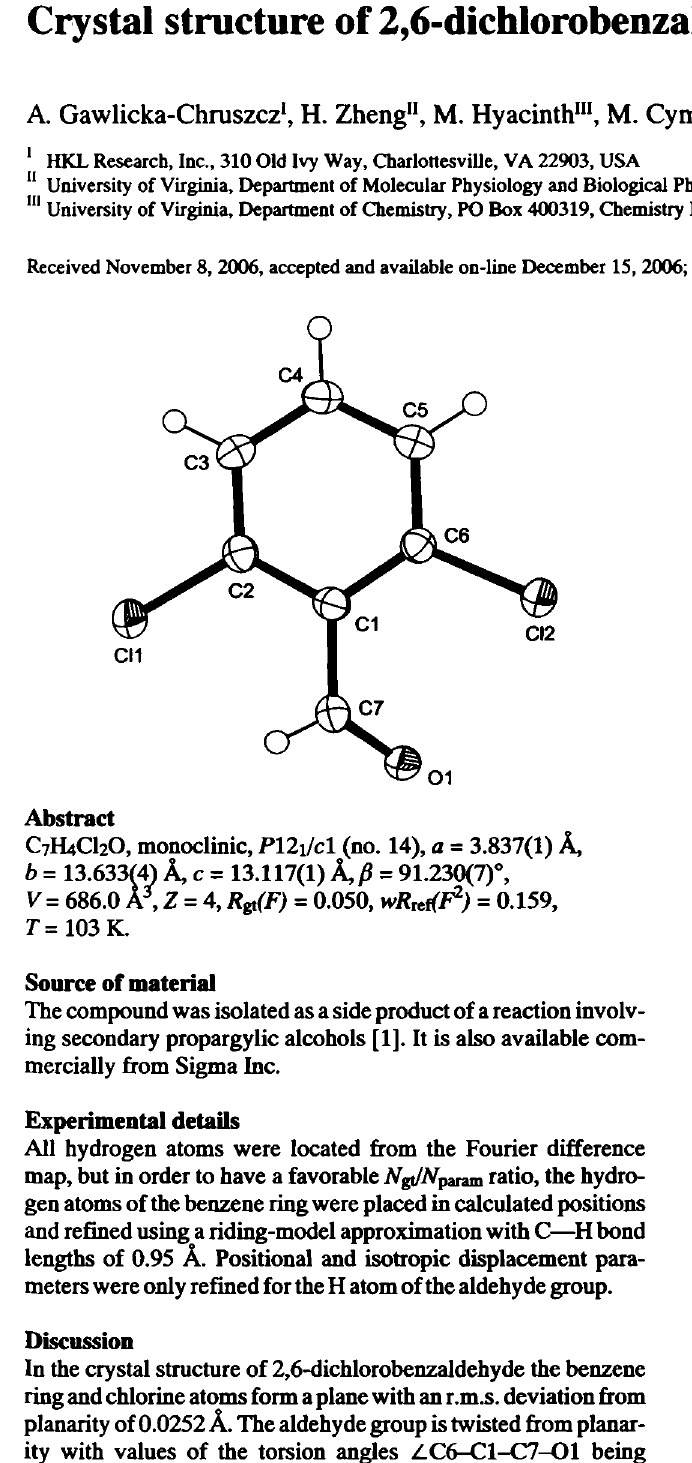
Table 2. Atomic coordinates and displacement parameters (in Ä 2